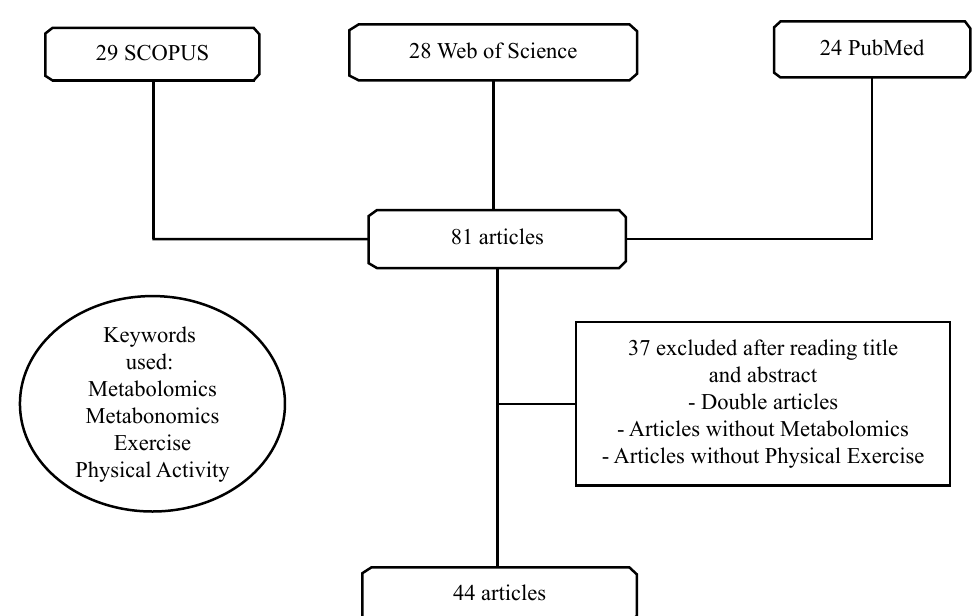
Figure 1. Flowchart of the selection of articles on metabolomics and physical exercise in